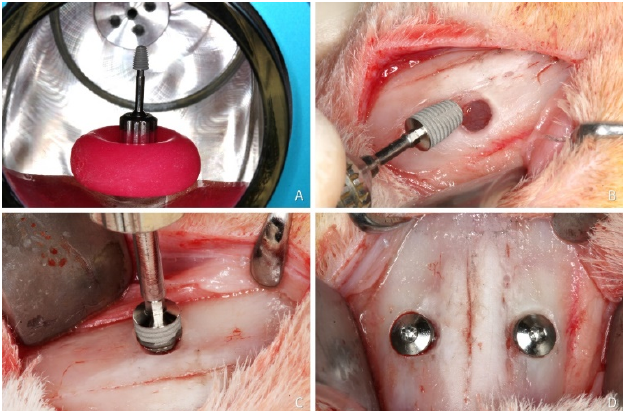
Figure 2. Surgical implantation procedure. ( A ), argon plasma reactor for the treatment of the surface of the test (plasma) implant. ( B ), osteotomy prepared. ( C ), implant placement. ( D ), cover screws were placed on both implants.